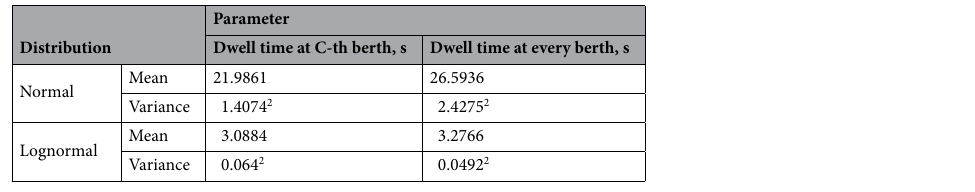
Table 1. Fitting